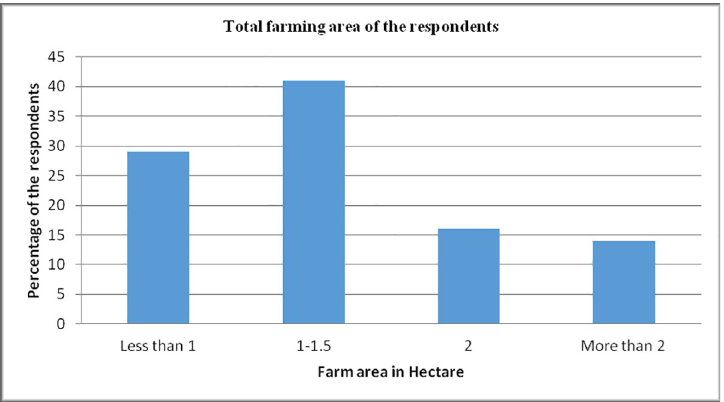
Fig 2. Total farming area of the respondents. Farming area of respondents in hectare represented in Fig 2. The area occupied by respondents in hectare was placed at x-axis while Y-axis represents the percentage of the respondents. Most of the respondents has farm area in the range of 1–1.5 hectare followed by less than 1 hectare however respondents having 2 or more than 2 hectares were having same trend.